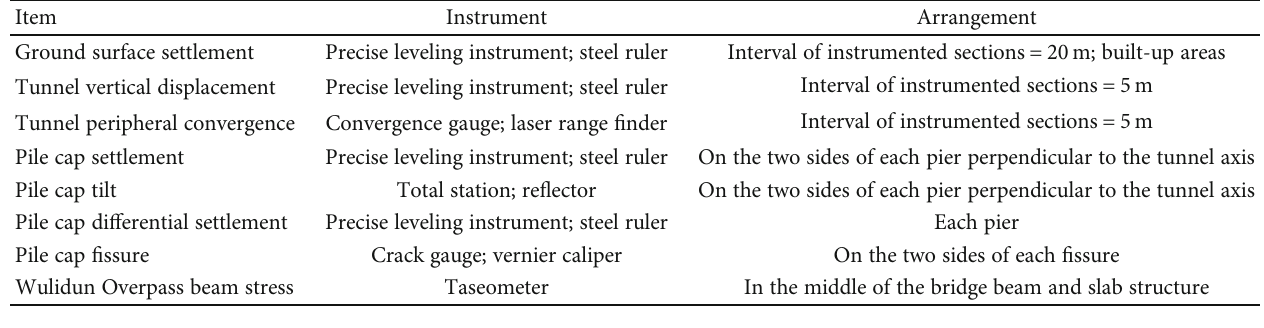
Table 1: Summary of the in situ monitoring information.